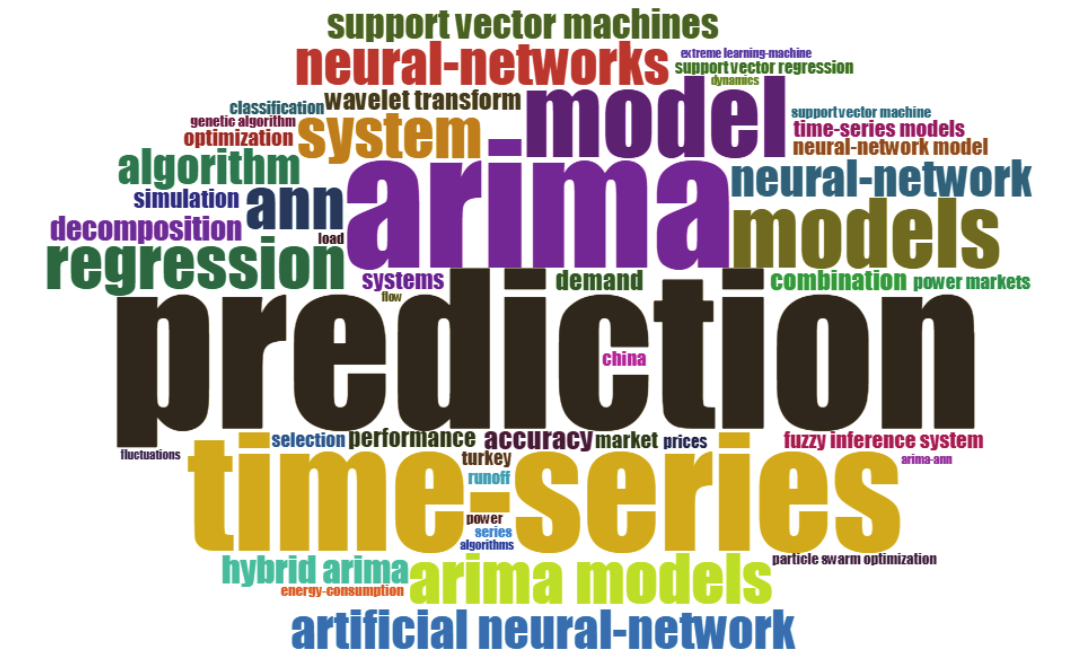
Fig. 2. The frequency of the keywords used in research topics with ARIMA and